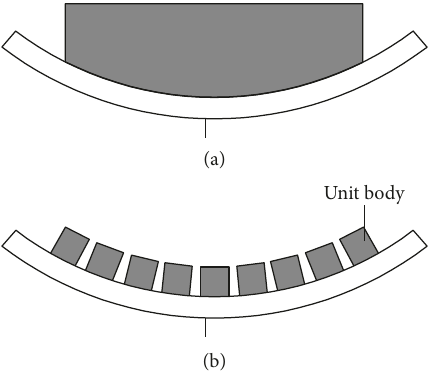
Figure 1: Comparison of traditional die and multipoint die. (a) Conventional die forming. (b) Flexible die forming.